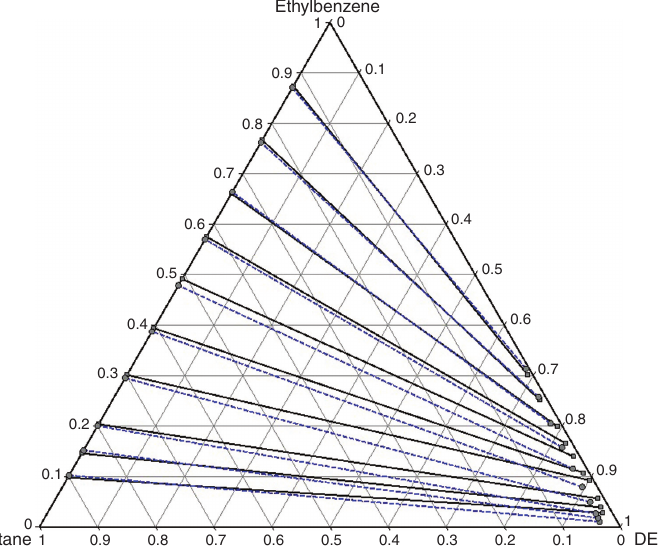
Figure 2: Experimental and calculated (dashed) tie lines for the ternary mixture ethyl benzene+ n -octane+DES2.